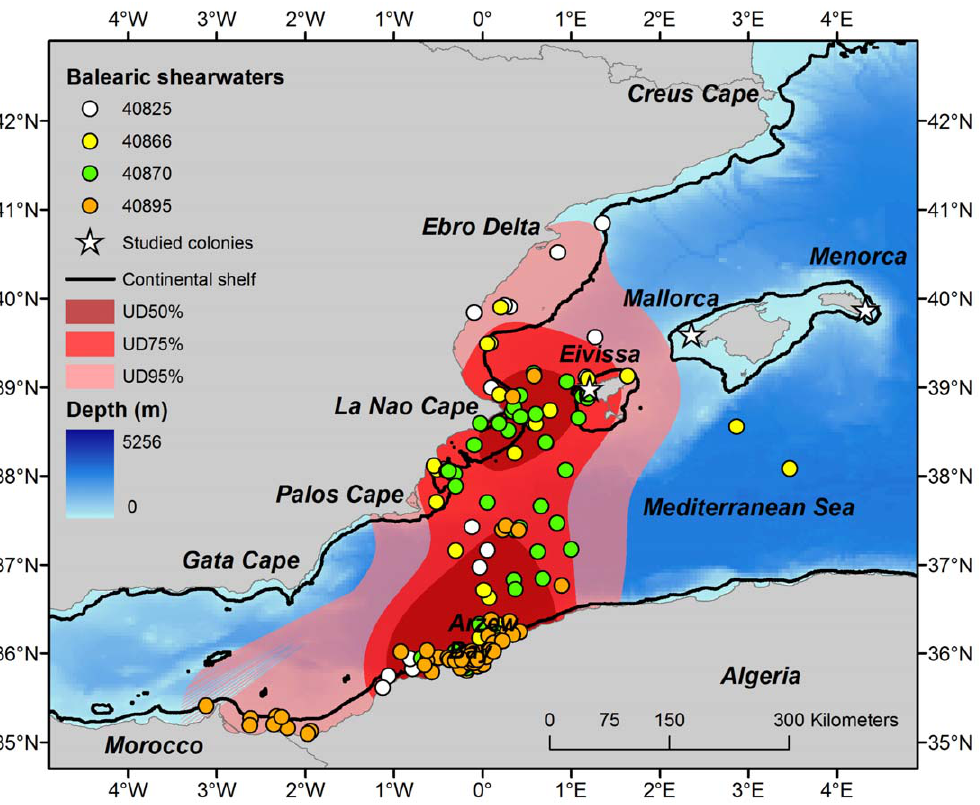
Figure 2. Filtered locations (each shearwater represented by different colours) and density contours (95%, 75% and 50% UD represented by black, dark grey and light grey lines, respectively) resulting from kernel estimation of the distribution of southern Balearic shearwaters during the chick-rearing period of 2011. Two main marine areas (indicated by the 50% UD) are identified: marine area around Cape La Nao and Arzew Bay in the Iberian and Algerian continental shelves, respectively. doi:10.1371/journal.pone.0035728.g002 African coast than Menorca) recurrently commute to the northern African coast (especially the Algerian coast, but also Morocco) at the end of the breeding season. The reason why shearwaters from Eivissa do not only forage over the closest productive area along